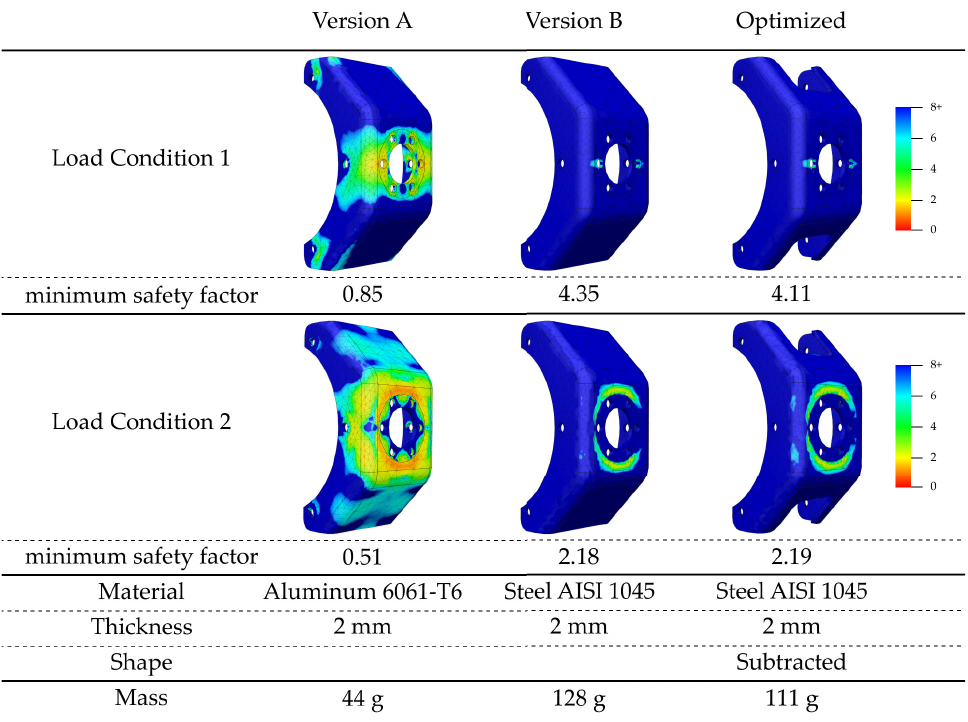
Figure 10. Optimization process of hip connector 1. The part has a thickness limit, so the strength needs are met by changing the material.